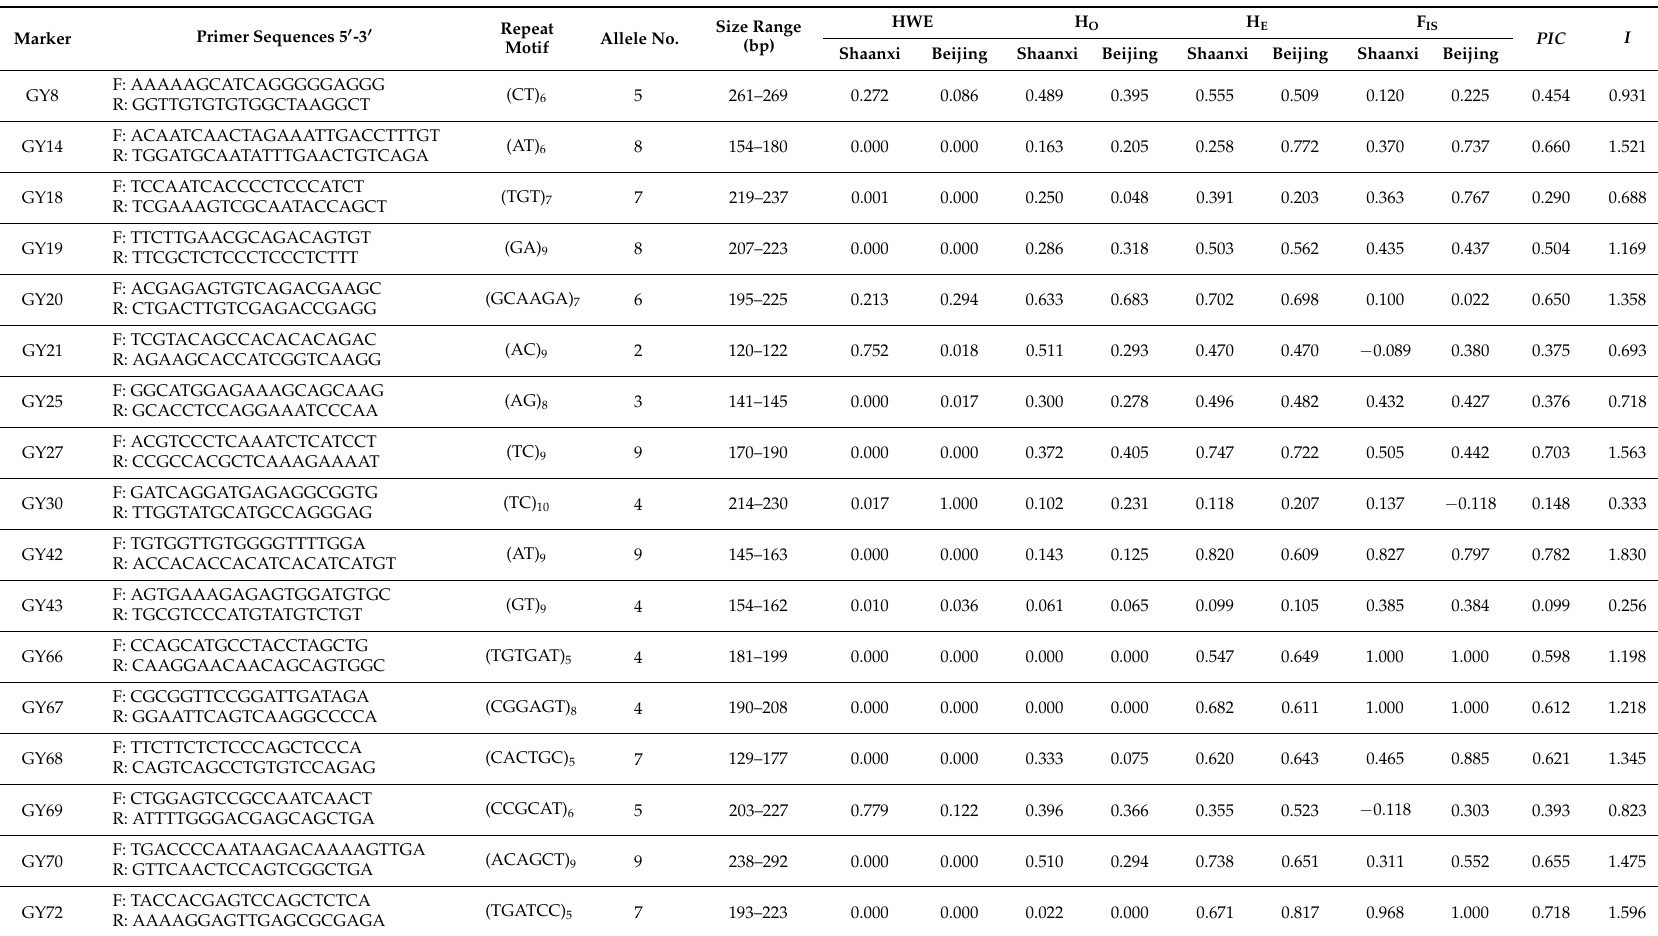
Table 5. Characteristics of 22 microsatellite loci validated on 96 individuals of G. yamadae from two geographical locations in